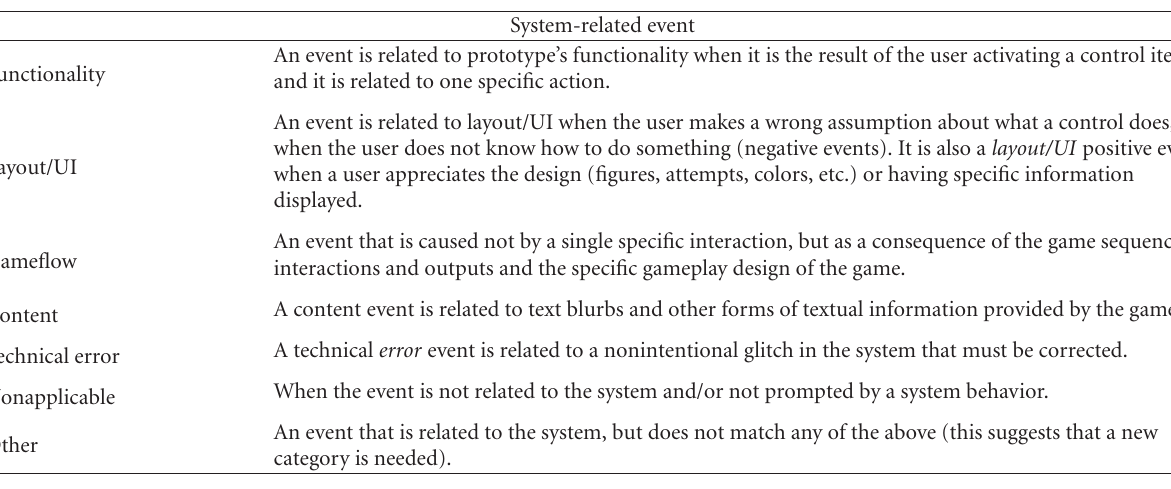
Table 1: Event categories for the system dimension.